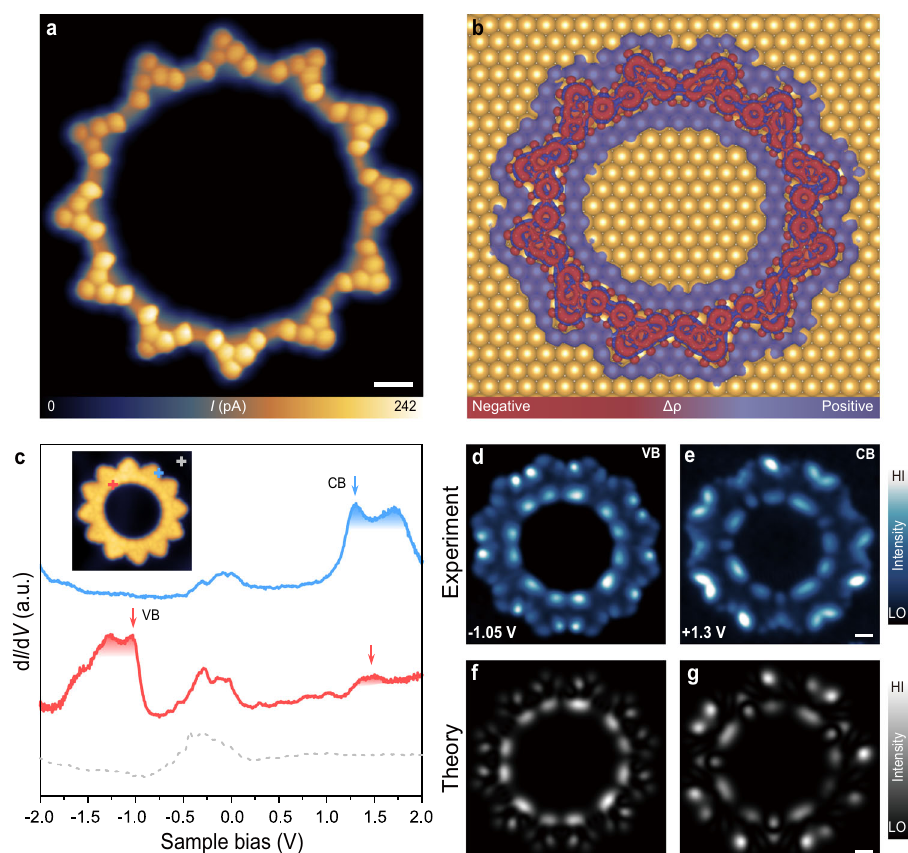
Fig. 2 Structural and electronic structure characterization of 12-OQC. a Corresponding BR-STM image ( V = 3 mV, Δ z = − 1.2 Å ; set point prior to turn off feedback, V = 20 mV, I = 600 pA). b 3D isosurface of the electronic density differences with an isovalue of ± 0.001 e / Å 3 of 12-OQC on Au(111) surface. Red and purple regions in 3D plots represent charge depletion and accumulation, respectively. c Point d I /d V spectra acquired over different sites of 12-OQC and Au(111) substrate. d I /d V curves taken at the pentagonal ring (blue curve), inner edge of 12-OQC (red curve), and taken on Au(111) (grey dashed curve). d , e Constant-current d I /d V maps recorded at the energy positions of the VB ( − 1.05 V) and CB ( + 1.3 V) of 12-OQC, respectively ( I = 2 nA for d , e ). f , g Simulated d I /d V maps acquired at different energy positions corresponding to different sets of orbitals: f ψ 1 ( − 0.68601 eV), ψ 2 ( − 0.67676 eV), ψ 3 ( − 0.65554 eV); g ψ 4 (1.03913 eV), ψ 5 (1.05283 eV), ψ 6 (1.06462 eV). Scale bar: 5 Å